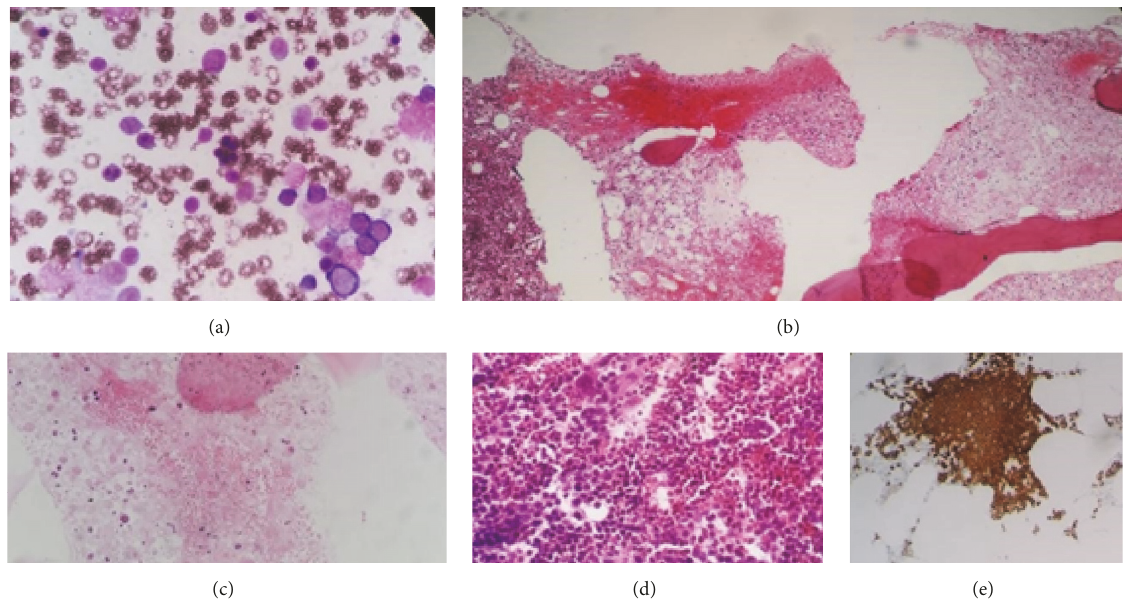
Figure 1: (a) Bone marrow aspirate showing an amorphous necrotic material (Giemsa stain × 100). (b) Extensive BMN in the trephine biopsy (H&E × 4). (c) Dilated sinus full of sickle cells in a background of ill-defined eosinophilic material (H&E × 40). (d) Intact area with erythroid hyperplasia (H&E × 40). (e) Spectrin stain showing the extent of erythroid hyperplasia (IHC, spectrin ×